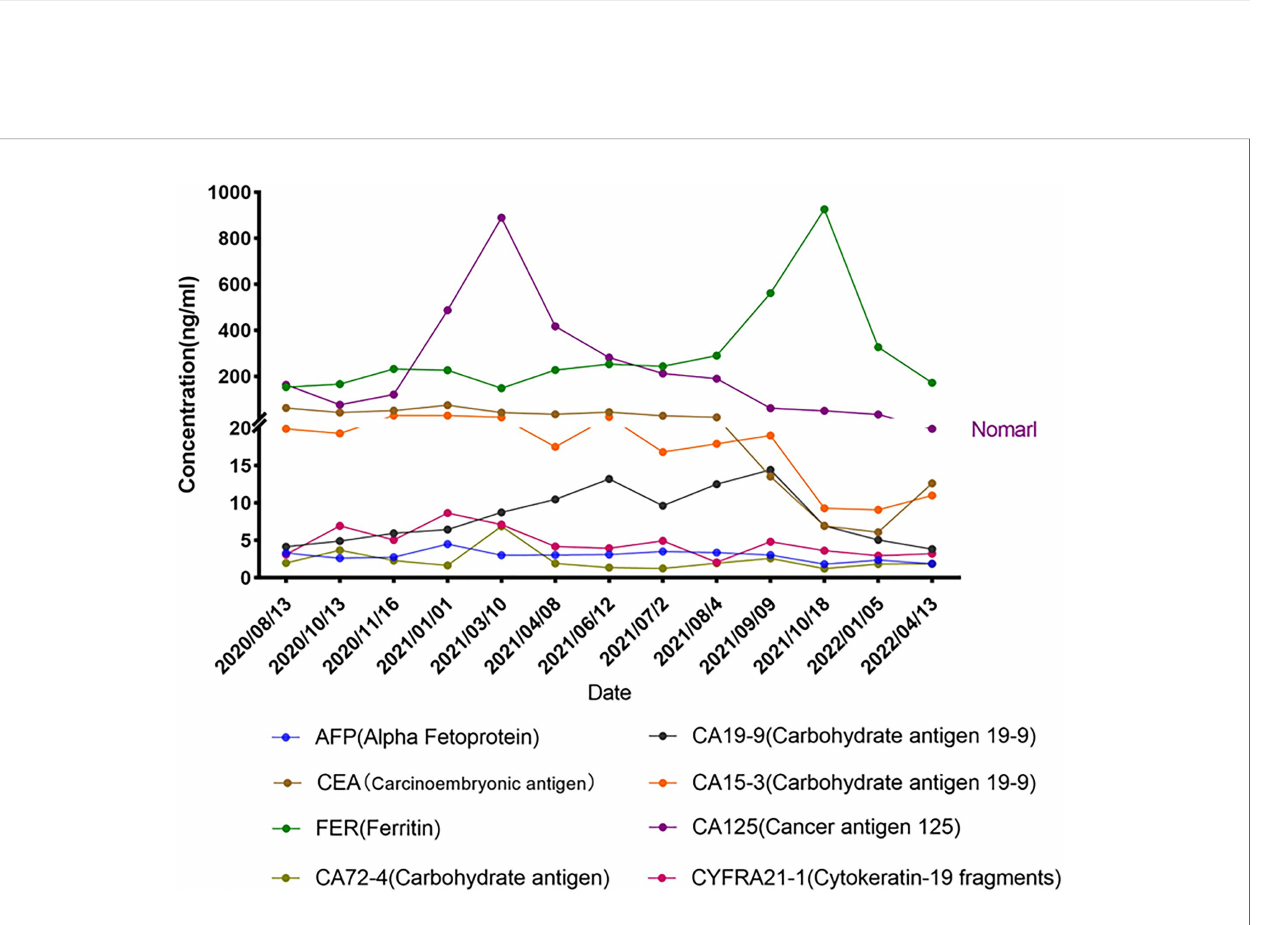
FIGURE 3 | Serum tumor biomarkers during treatment.